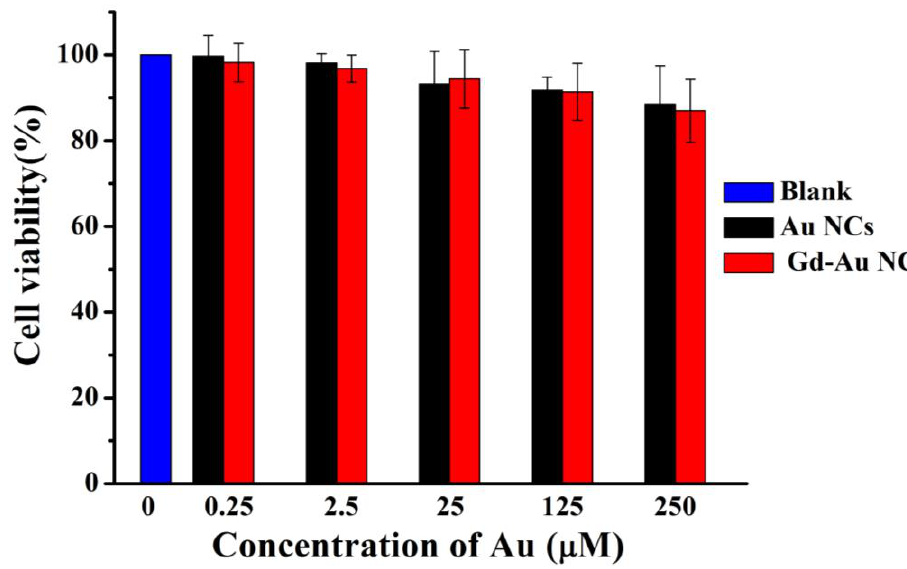
Figure 4. In vitro cytotoxicity of Au NCs (black) and Gd-Au NCs (red) against breast cancer cell line (MCF-7) after 24 h.